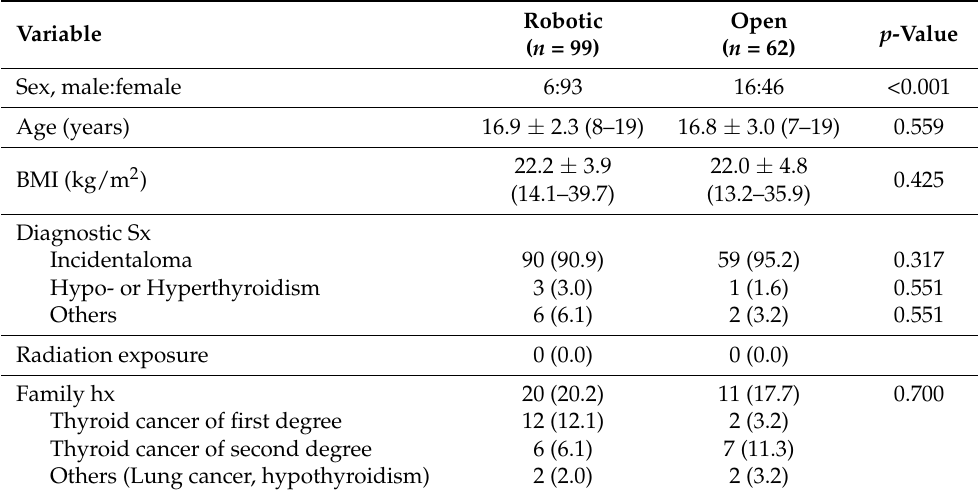
Table 1. Clinical characteristics of patients with thyroid cancer treated with robotic versus open thyroidectomy.